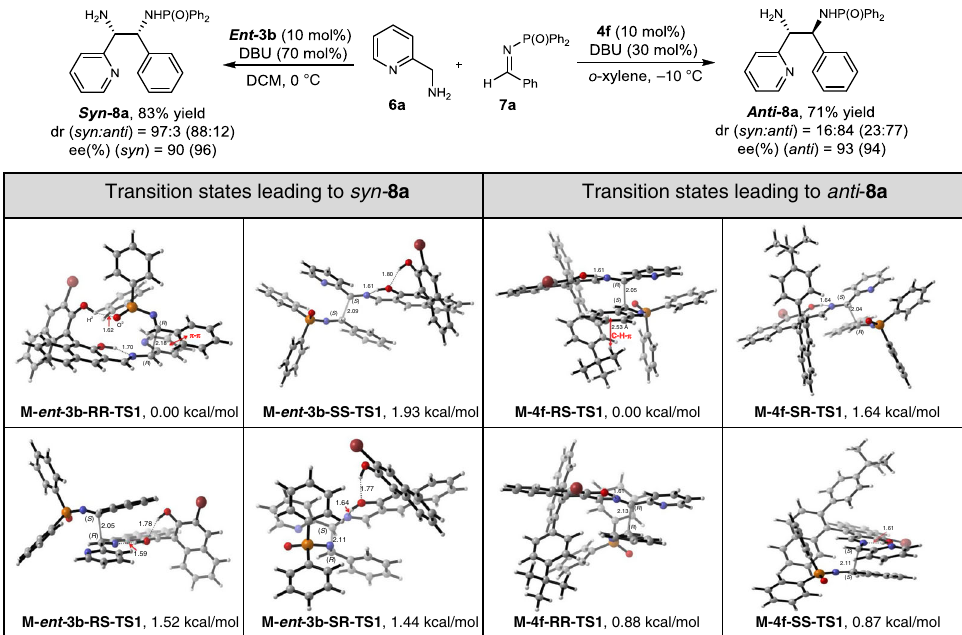
Fig. 5 Calculated transition states of Mannich reaction. The structures of TSs to form 8a by Mannich reaction catalysed by ent -3b and 4f at the M06-2X/ 6-31(d) // M06-2X/6-31 + + G(d,p) level and energy are given in kcal/mol relative energy of M-ent-3b-RR- TS1 and M-4f-RS-TS1 . Dr and ee values shown in the parentheses are the predicted data by the computational